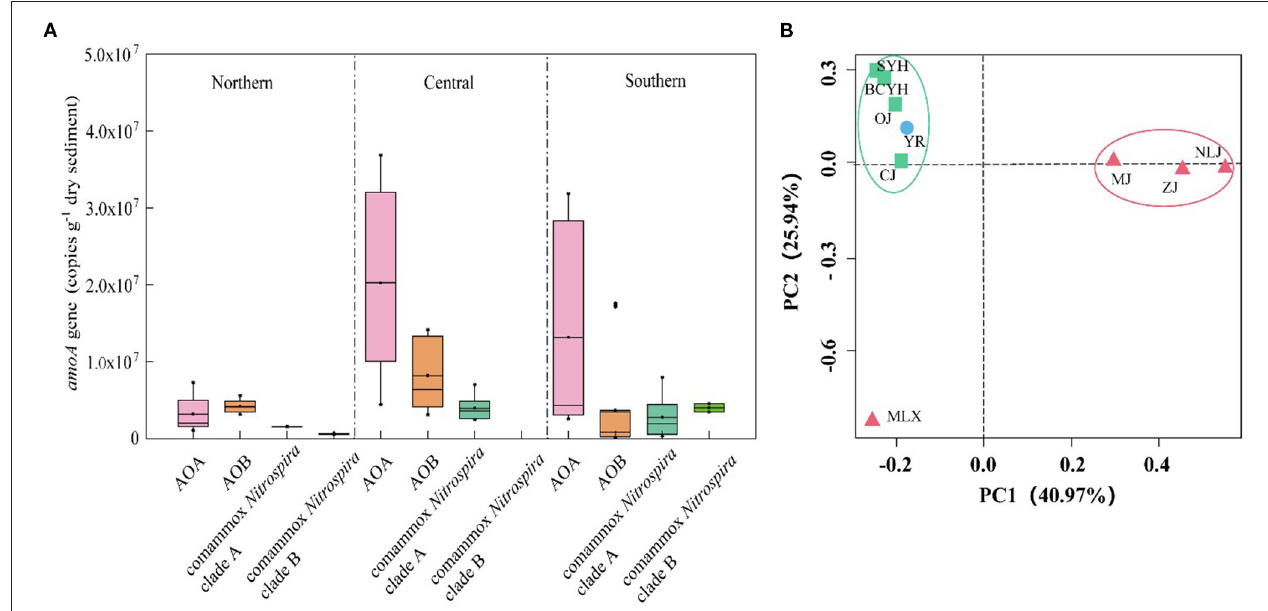
FIGURE 4 | (A) Abundance of ammonia-oxidizers in the distinct areas based on qPCR results. (B) UniFrac weighted PCoA analysis of comammox Nitrospira communities in the estuary tidal flat wetlands of China. Red triangle: Southern estuaries (MJ, ZJ, MLX, NLJ); Green square: Central estuaries (BCYH, SYH, CJ, OJ); Blue circle: Northern estuaries (YR).